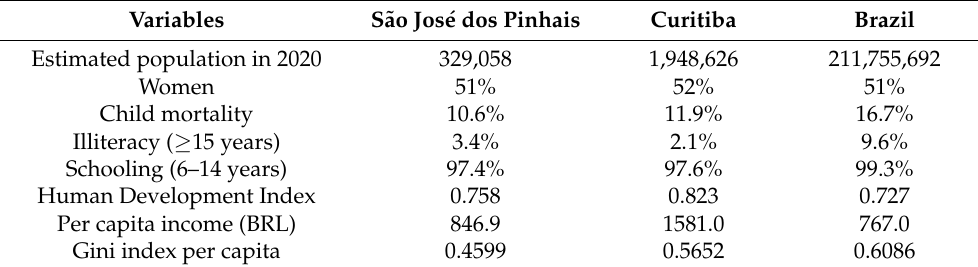
Table 1. Socioeconomic, health-related, and demographic indicators of S ã o Jos é dos Pinhais, Curitiba, and